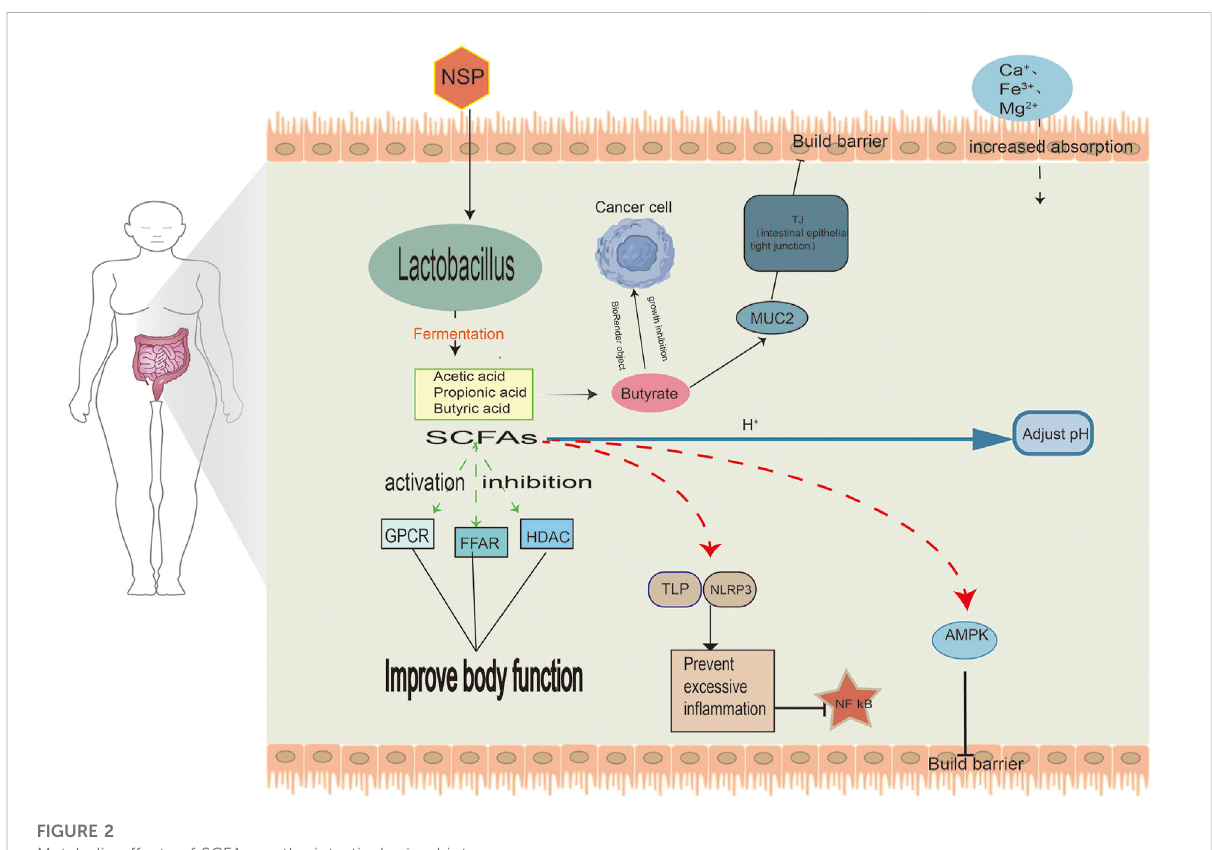
FIGURE 2 Metabolic effects of SCFAs on the intestinal